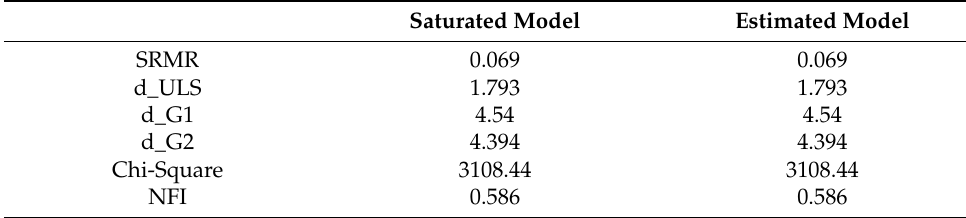
Table 8. Model fit summary.